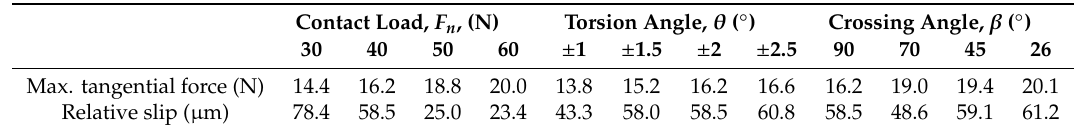
Figure 6. F t - D loops during tension–torsion cyclic loading of steel wires with fretting contact in cases of distinct contact loads. ( a ) F n = 30 N. ( b ) F n = 40 N. ( c ) F n = 50 N. ( d ) F n = 60 N. Table 5. Tangential forces and relative slips between steel wires during tension–torsion cyclic loading at loading cycles 20,000 with different tension–torsion cyclic loading parameters.